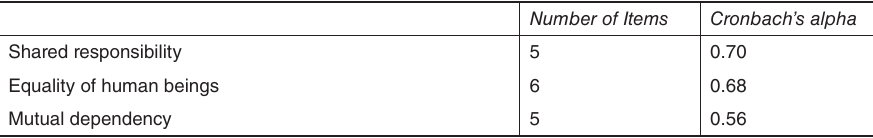
Table 4: Reliability of scales